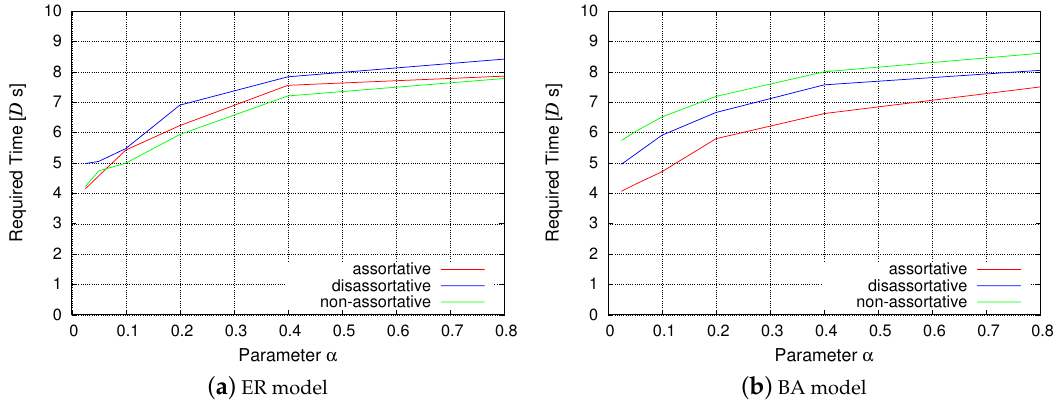
Figure 8. Communication efficiency (propagation delay).